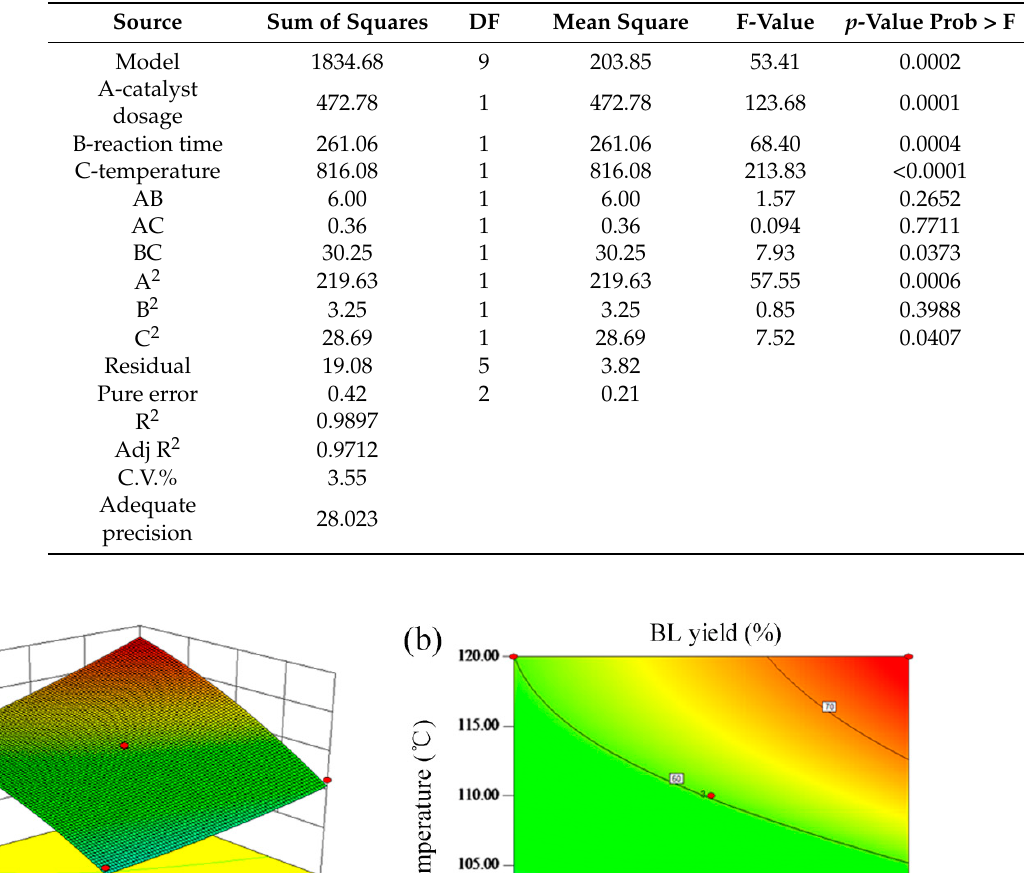
Figure 8. ( a ) Plots of the predicted vs. experimental results for the BL yield and ( b ) the normal probability plot of the residuals for the BBD model. Table 3. ANVOA for the optimized RSM model.